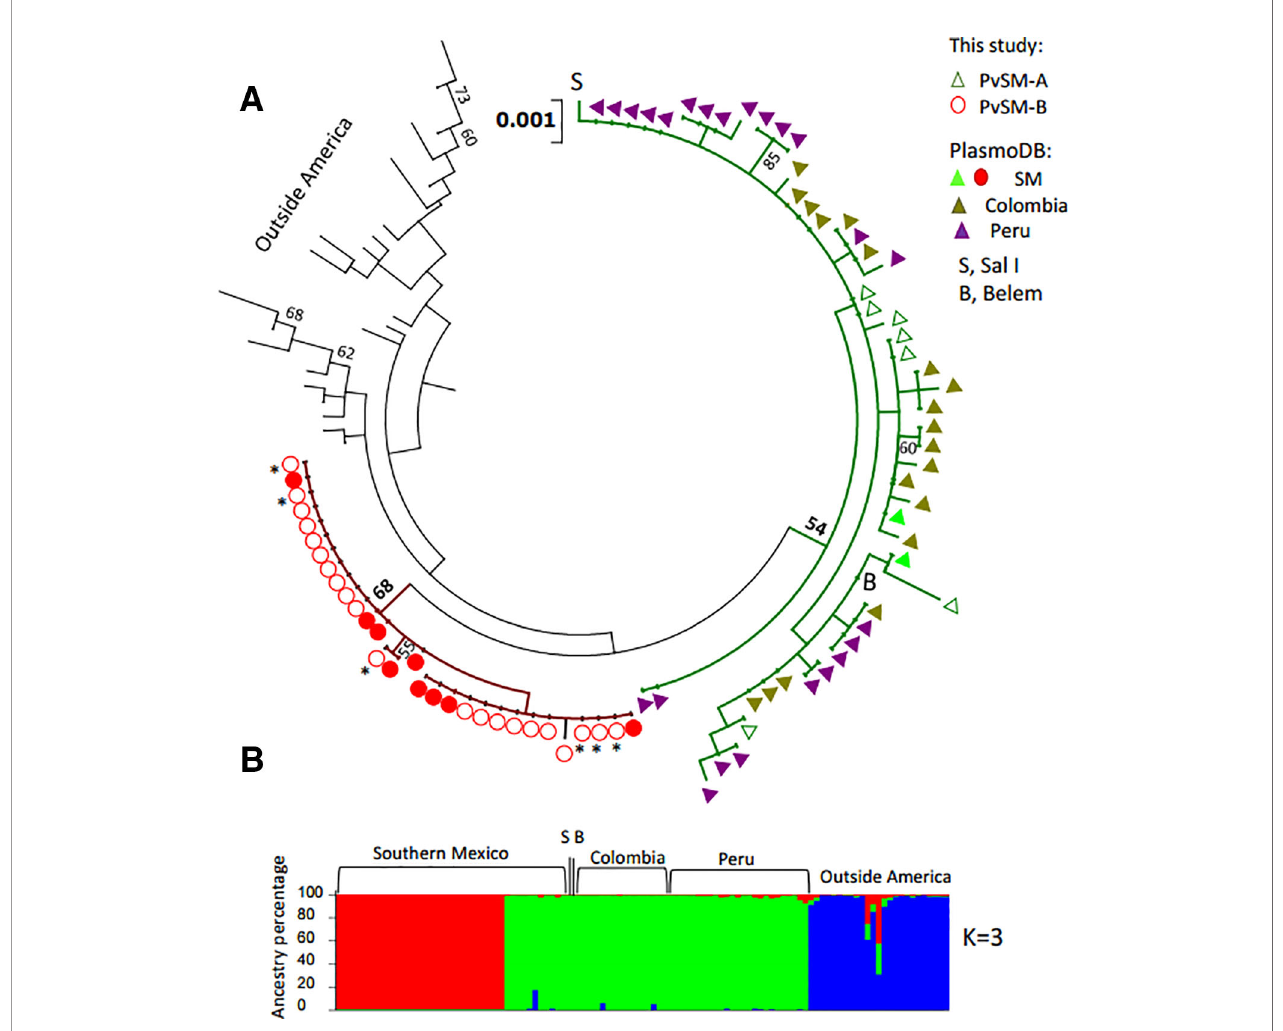
FIGURE 2 | Phylogenetic tree and genetic structure of concatenated gene sequences of Plasmodium vivax ookinete proteins of southern Mexican and worldwide isolates. (A) Maximum Likelihood method based on the HKY+G model. The phylogenetic reconstruction tree was run with 1,000 replicates. Isolates of PvSM-A lineage and others from America clustered together (green branch), while another batch of isolates from southern Mexico clustered separately, including PvSM-B lineage (red branch). Parasites from outside Latin America are comprised in black branches. Bootstrap values above 50% are indicated; *indicates PvSM-Bb parasites. (B) Genetic structure analysis resolved three subpopulations as the most probable, each indicated by different colors: red shows only SM isolates, green shows PvSM-A plus other parasites from Latin America and blue shows parasites from outside America that clustered in one population. S, Sal I strain; B, Belem strain. The analysis involved 109 global nucleotide sequences of 2478 bp. Pvs25 , pvs28 , soap celtos , and ctrp gene fragments were included.